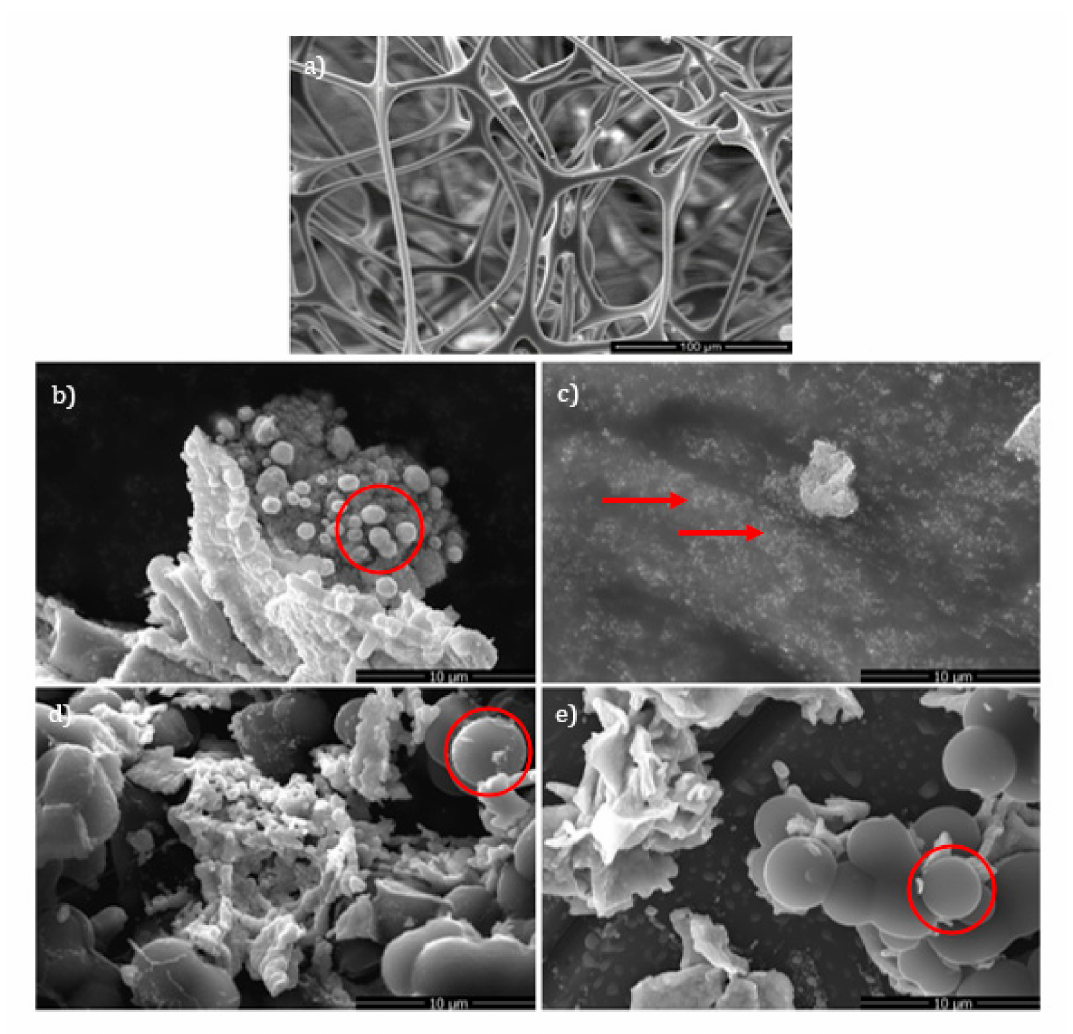
Figure 2. SEM images of ( a ) MF, ( b ) and ( c ) MF_10Cu, ( d ) MF_M_10Cu and ( e ) MF_U_10Cu. As expected, all samples have similar morphologies [17]. Figure 2a shows the struc- ture of the foam without any coating. In Figure 2b,d,e, this structure is covered by the respective CX solutions. As mentioned by other authors, it is proven that CX is made up of interconnected spherical particles (circled), and the MFs have a porous structure in the shape of a honeycomb [34,35]. Figure 2c shows bright spots (marked with arrows) corresponding to the copper particles, which indicates a homogeneous copper distribution throughout the